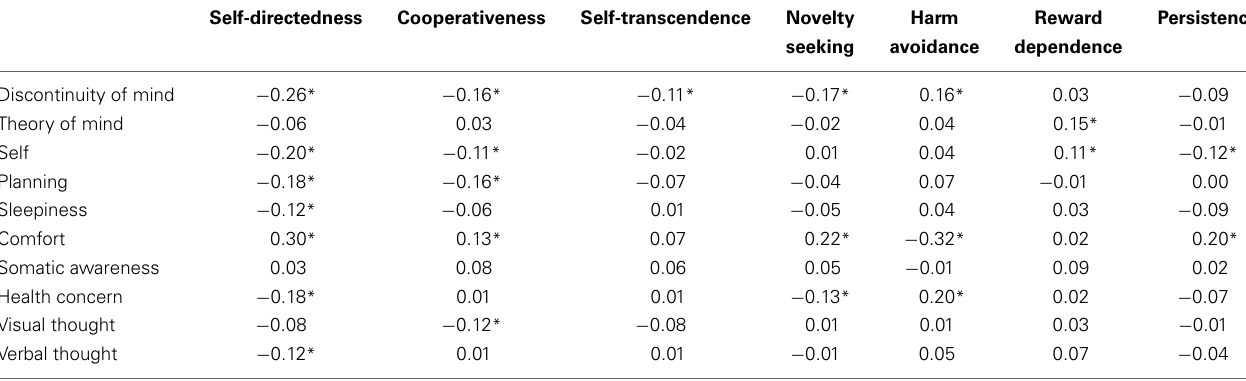
Table 3 | Correlation matrix of ARSQ 2.0 factors and IPIP personality dimensions based on Cloninger’s psychobiological model (Cloninger et al., 1993; Goldberg et al.,